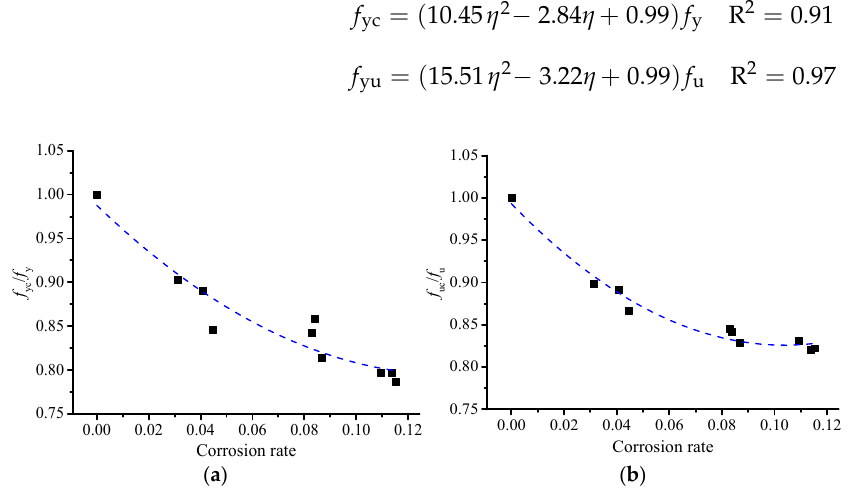
Figure 9. Strength normalization value—( a ) f yc / f y —corrosion rate , ( b ) f uc / f u —corrosion rate.